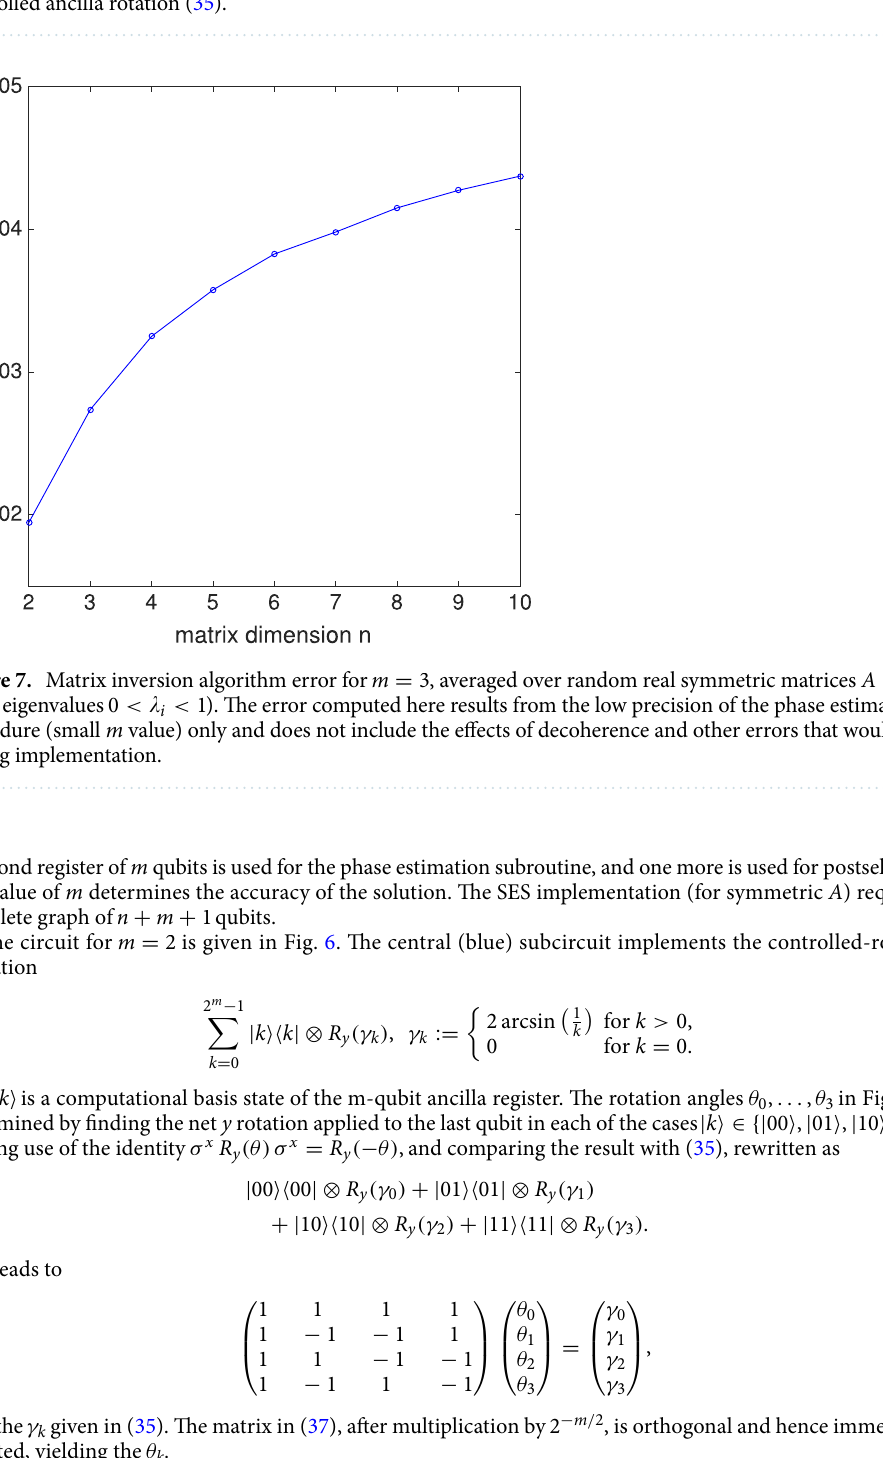
Figure 6. Quantum circuit for n × n matrix inversion with m = 2 . Here H is the Hadamard gate, U = e iAt 0 / 2 the vertical line connecting crosses is a SWAP gate, r = | 0 �� 0 | + i | 1 �� 1 | is a z rotation, and R y = e − i (θ/ 2 )σ rotation. The small (yellow) subcircuits are Fourier transforms and the central (blue) subcircuit implements the controlled ancilla rotation (35).